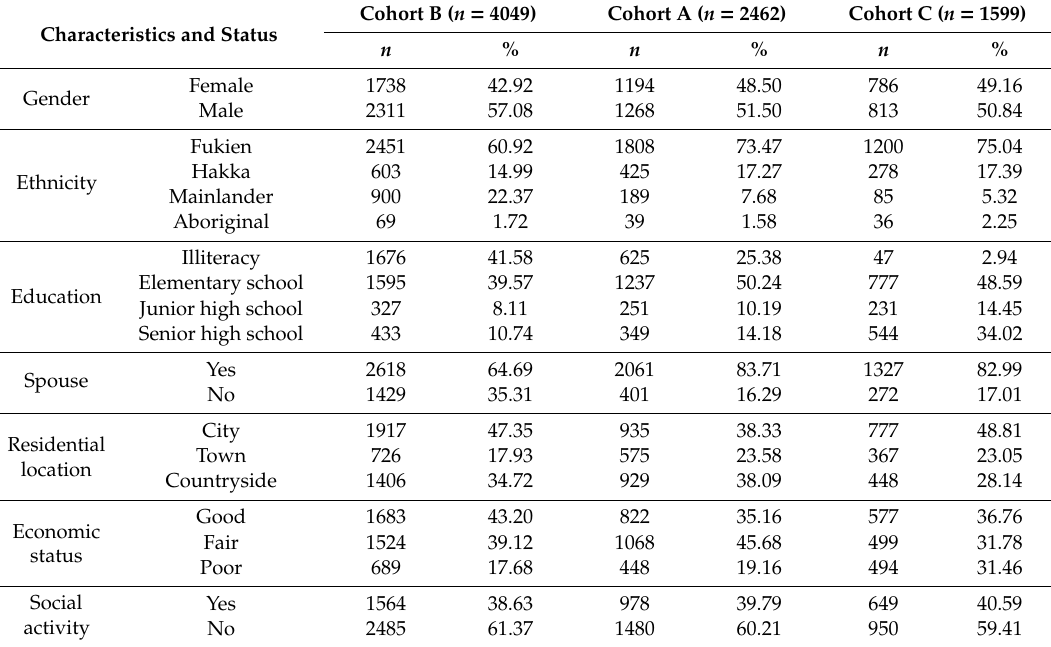
Table 1. Characteristics and status of di ff erent cohorts at the baseline survey.